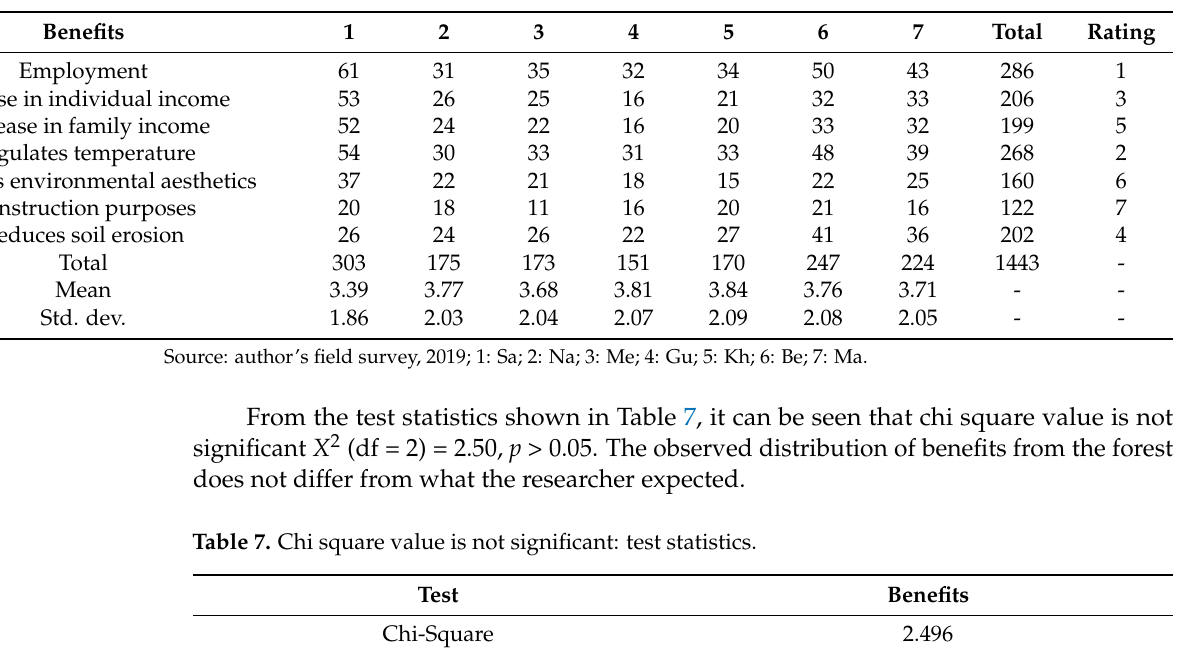
Table 6. Contributions of the forest to the host community.